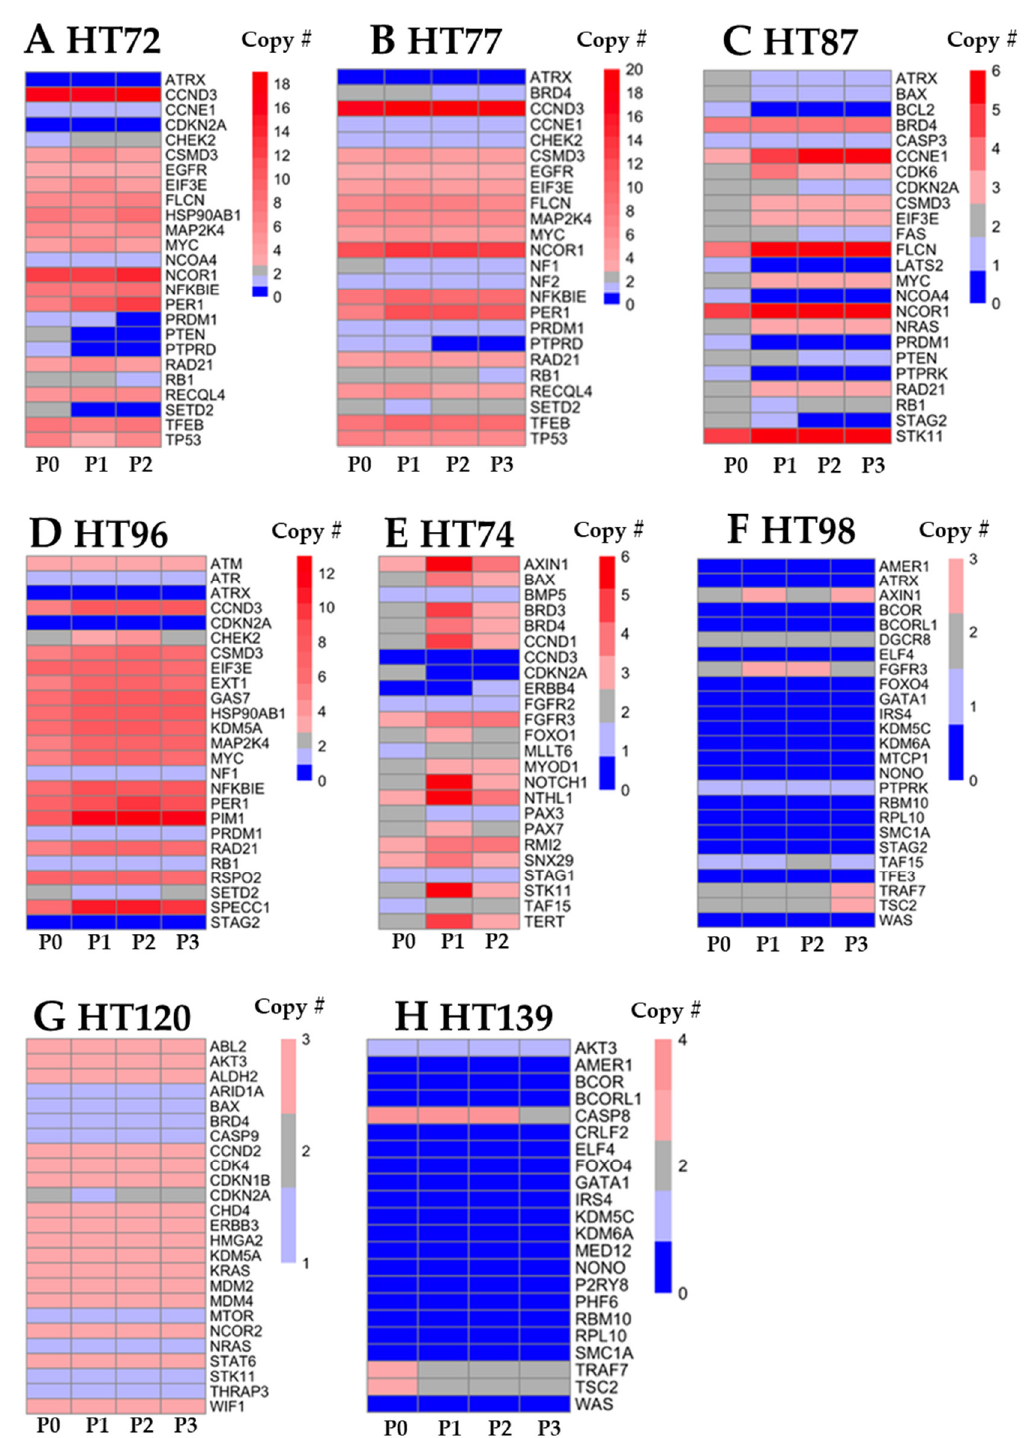
Figure 3. Distribution of copy number events involving 25 COSMIC-associated genes in P0 tumors and corresponding PDX passages. ( A ) HT72 (OS), ( B ) HT77 (OS), ( C ) HT87 (OS), ( D ) HT96 (OS), ( E ) HT74 (RMS), ( F ) HT98 (Wilms tumor), ( G ) HT120 (Wilms tumor), and ( H ) HT139 (Wilms tumor). All data were filtered against normal control (NA12878). Copy # = copy numbers; Neutral = 2 copies,